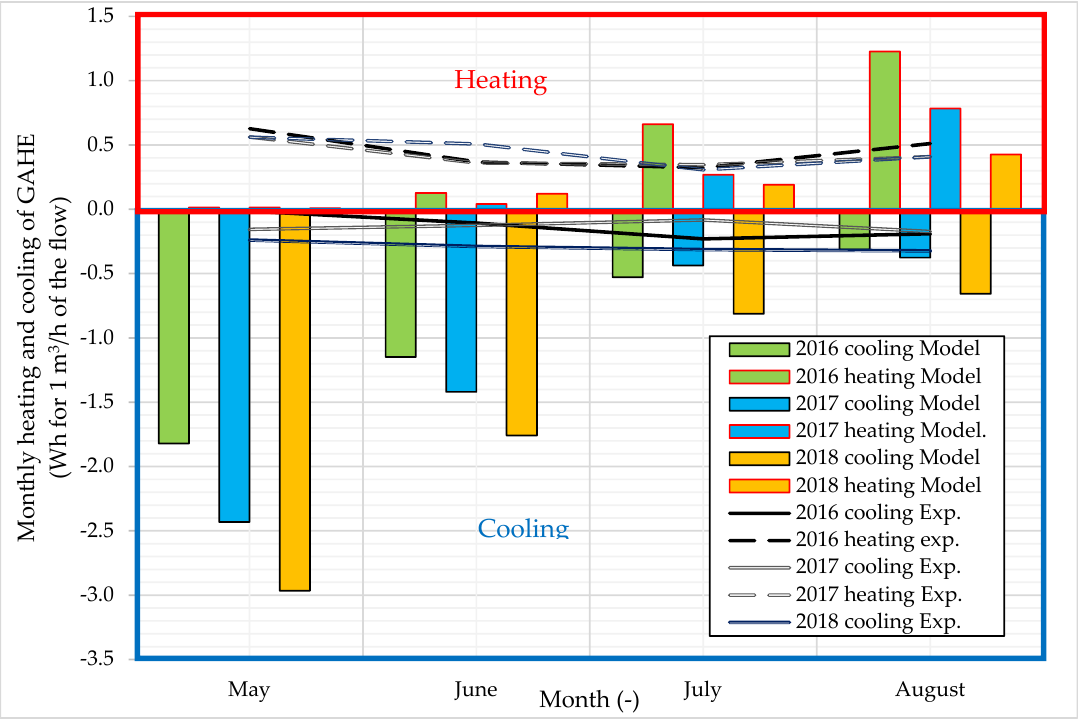
Figure 6. Monthly heating and cooling loads of the GAHE (Wh per 1 m 3 /h of flowing air).